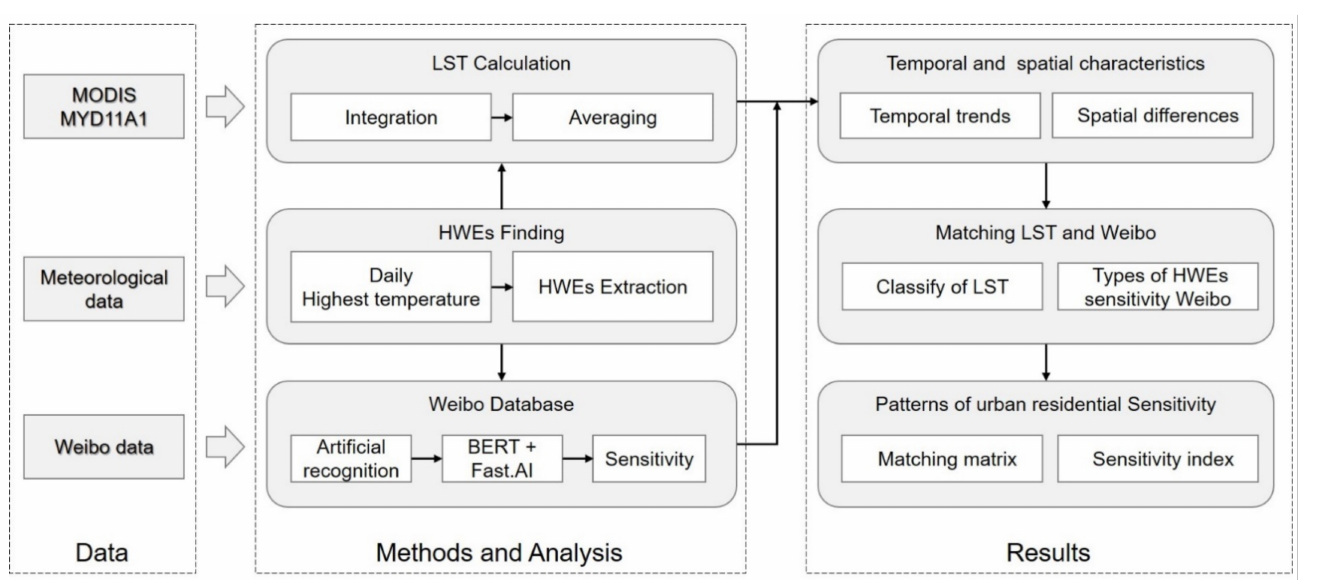
Figure 2. The research framework of this